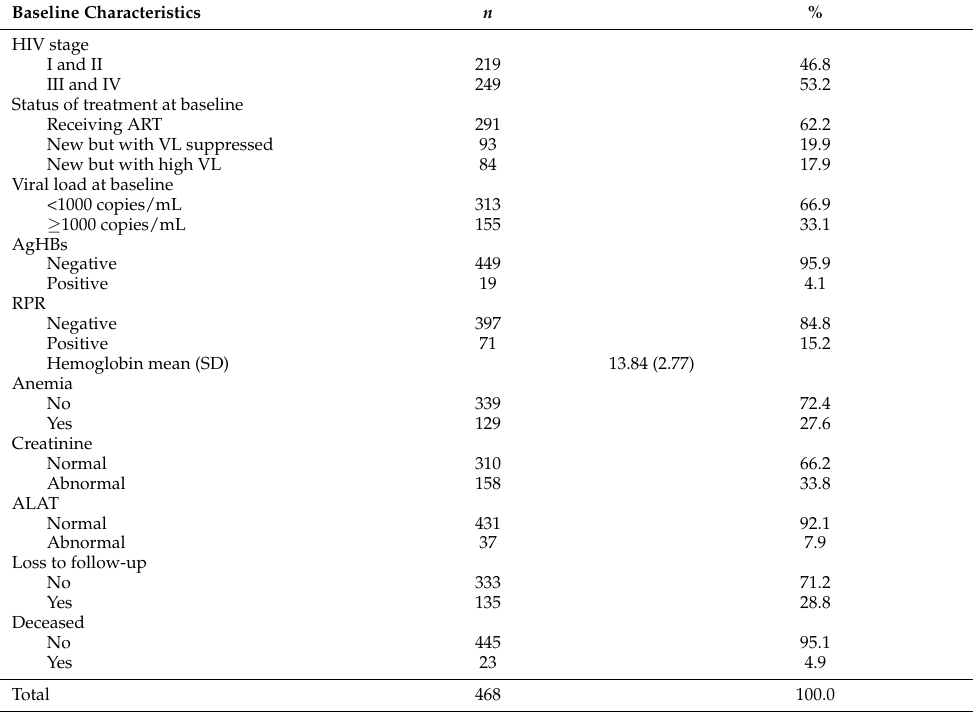
Table 2. Clinical and biological baseline characteristics ( n =